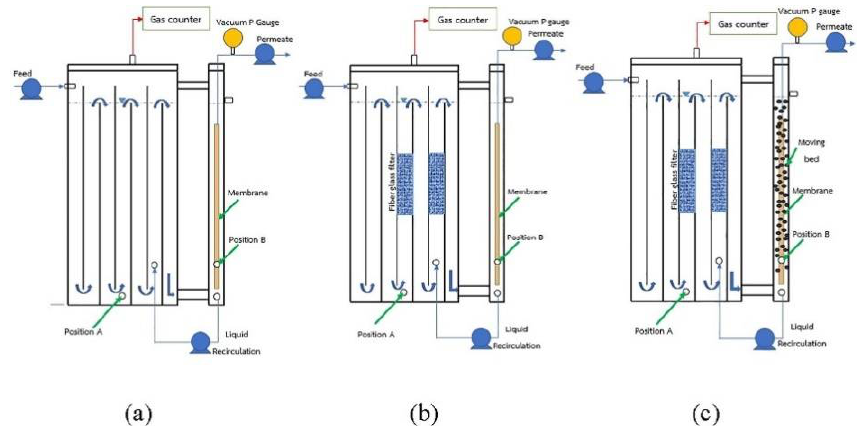
Figure 22. Three anaerobic baffled biofilm-membrane bioreactor (AnBB-MBR). ( a ) R1: no media (anaerobic baffled MBR); ( b ) R2:FF (fixed film AnBB-MBR); ( c ) R3:FF + MVB (fixed film and moving bed AnBB-MBR) [121].